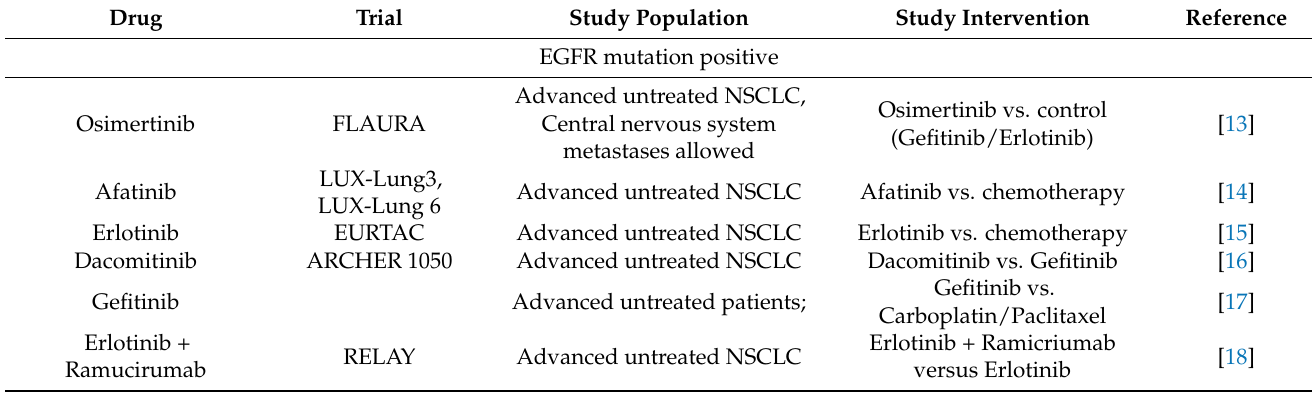
Table 1. Clinical trials leading to FDA approval of drugs for advanced NSCLC-targeted therapies.